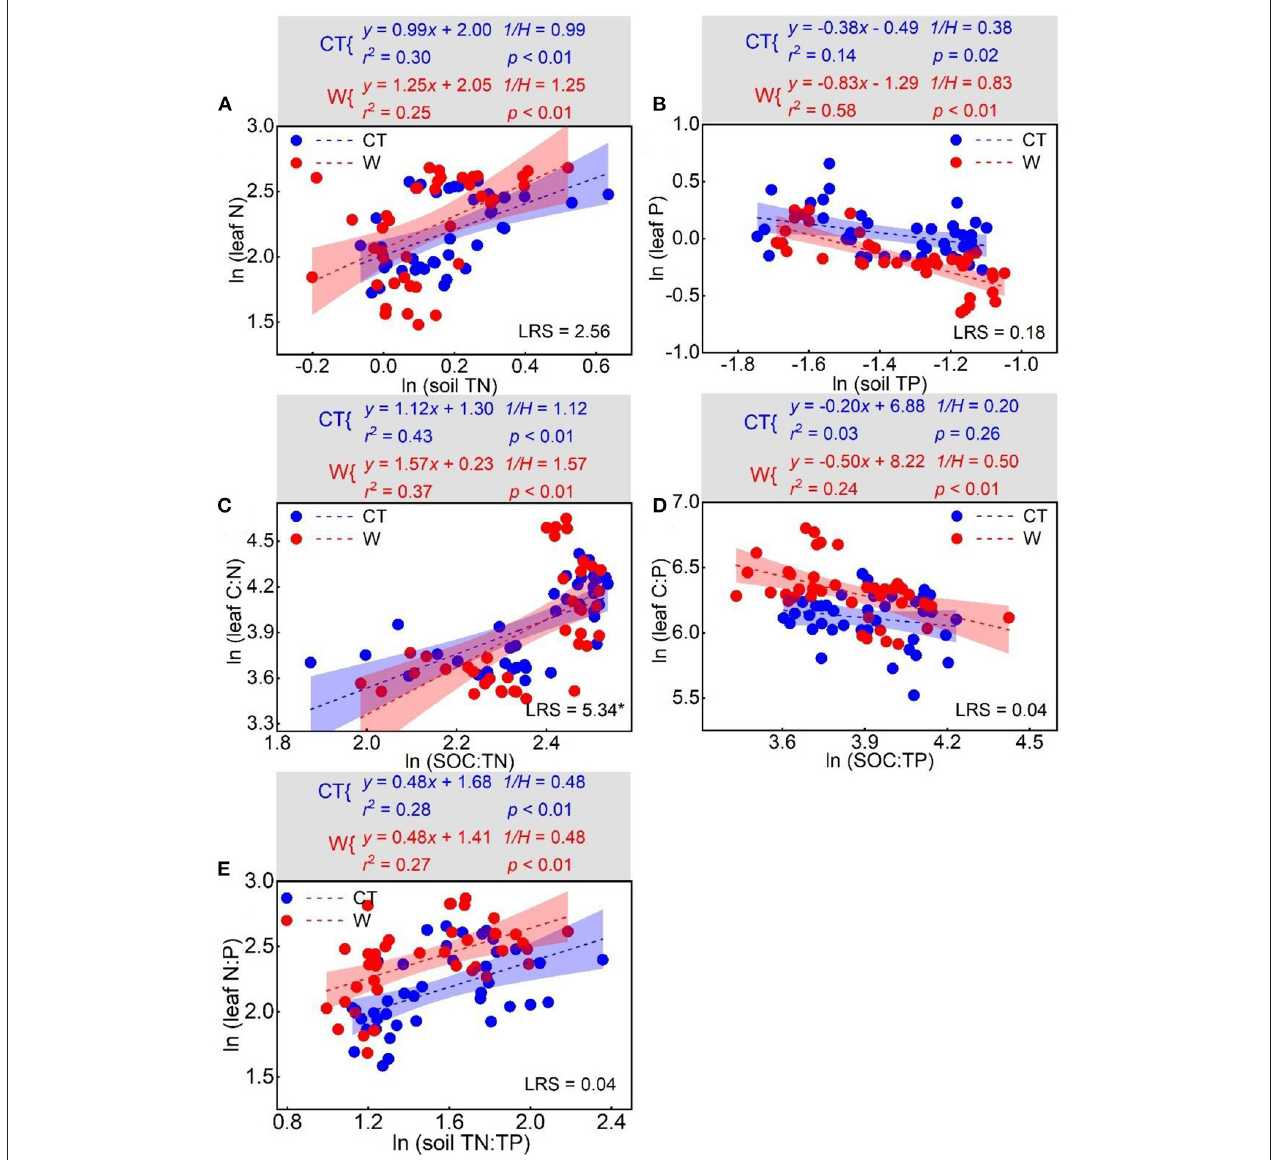
FIGURE 5 | Relationships between log-transformed stoichiometries of leaf and soil resources for N homeostasis (A) , P homeostasis (B) , C:N homeostasis (C) , C:P homeostasis (D) , and N:P homeostasis (E) under control and warming treatments. LRS (likelihood ratio statistic) was the result of standardized major axis estimation for the relationships (slopes) between leaf and soil resources (control vs. warming). Significant LRS indicated the relationships were different at * p < 0.05.